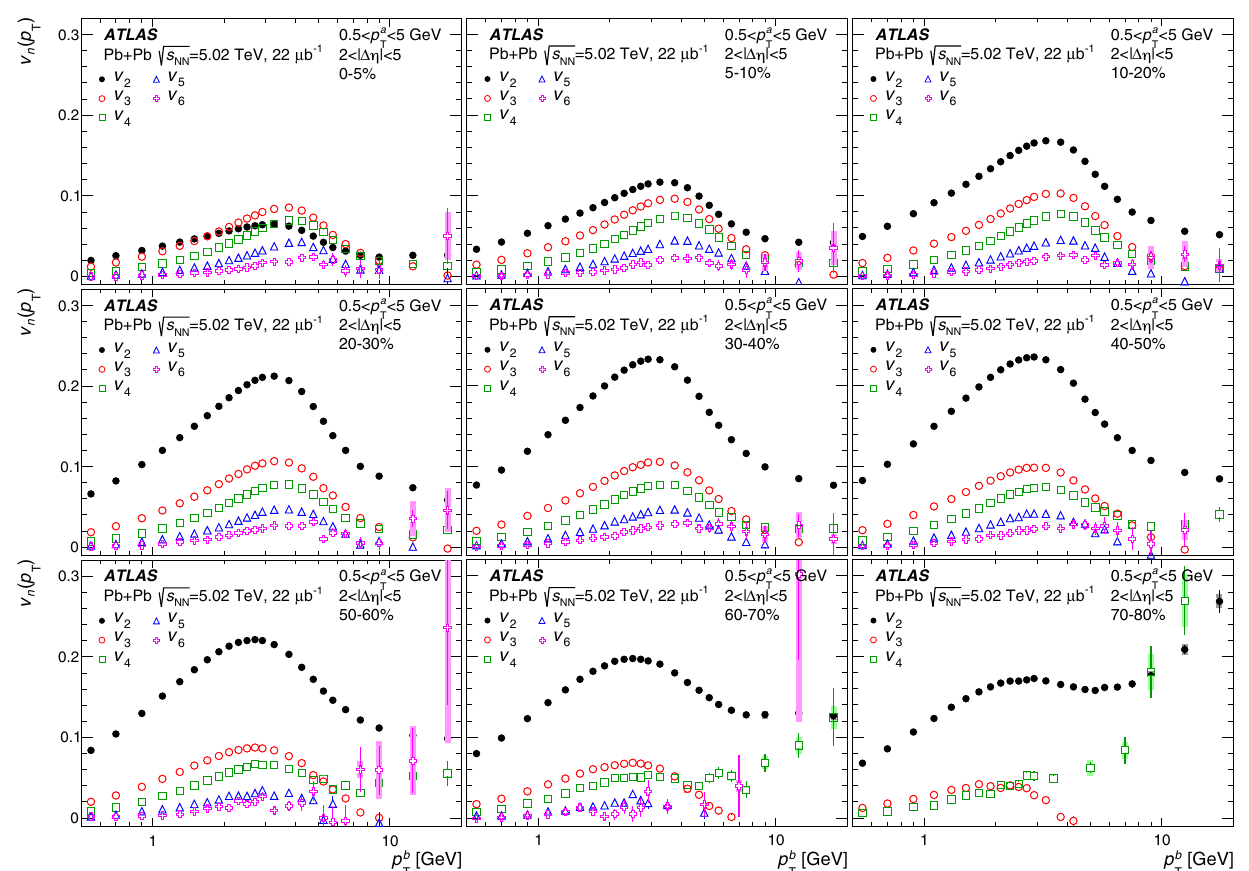
< 5 GeV. Each panel represents a different centrality for 0 . 5 < p a T T